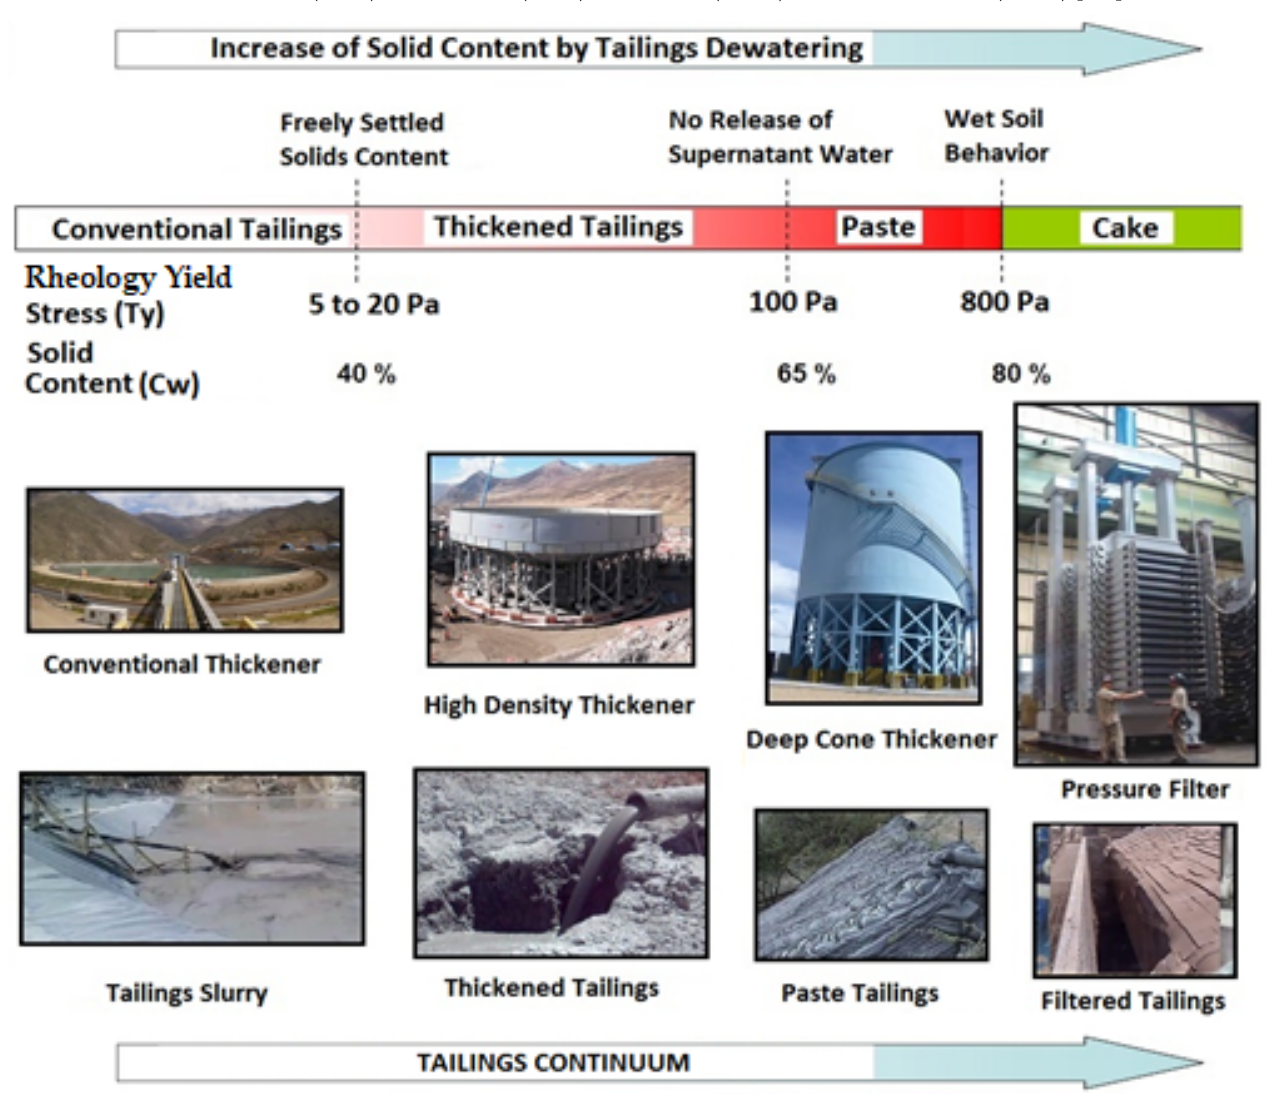
Figure 1. Dewatering Tailings Technologies–Tailings Dewatering Continuum [11].